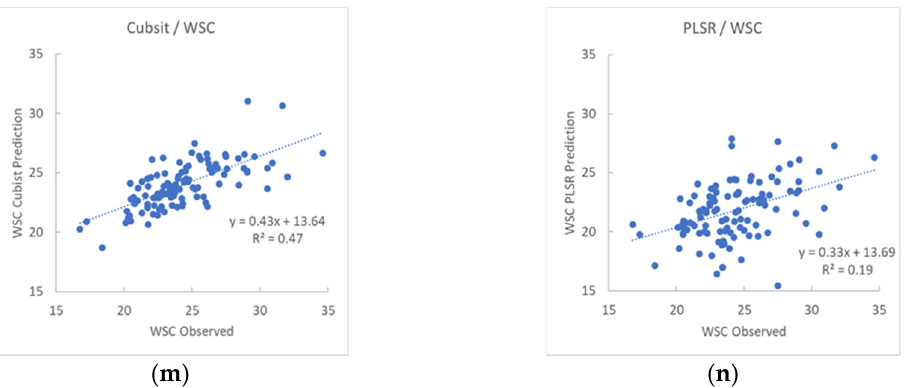
Figure 3. Comparison of predictive models developed using cubist and predictive models developed with partial least square regression (PLSR). (a) Regression between Lab results for acid detergent fibre (ADF) and the Cubist model predicted results for ADF. (b) Regression between Lab results for ADF and the PLSR model predicted results for ADF. (c) Regression between Lab results for ash and the Cubist model predicted results for ash. (d) Regression between Lab results for ash and the PLSR model predicted results for ash. (e) Regression between Lab results for crude protein (CP) and the Cubist model predicted results for CP. (f) Regression between Lab results for CP and the PLSR model predicted results for CP. (g) Regression between Lab results for dry matter (DM) and the Cubist model predicted results for DM. (h) Regression between Lab results for DM and the PLSR model predicted results for DM. (i) Regression between Lab results for in vivo dry matter digestibility (IVDMD) and the Cubist model predicted results for IVDMD. (j) Regression between Lab results for IVDMD and the PLSR model predicted results for IVDMD. (k) Regression between Lab results for (NDF) and the Cubist model predicted results for NDF. (l) Regression between Lab results for NDF and the PLSR model predicted results for NDF. (m) Regression between Lab results for water soluble carbohydrates (WSC) and the Cubist model predicted results for WSC. (n) Regression between Lab results for WSC and the PLSR model predicted results for